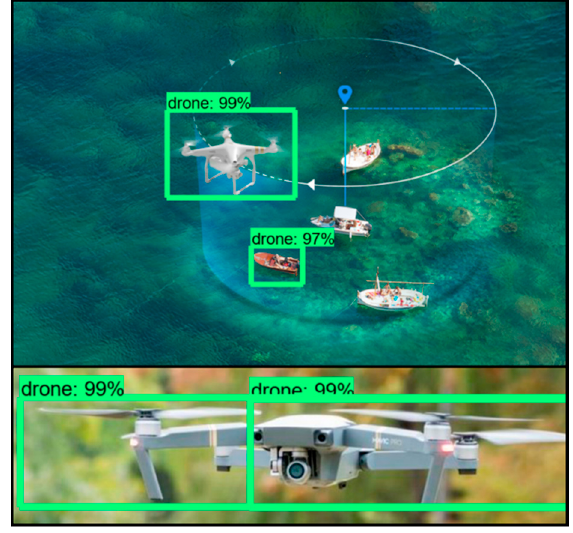
Figure 18. Incorrect drone detection in a static image.